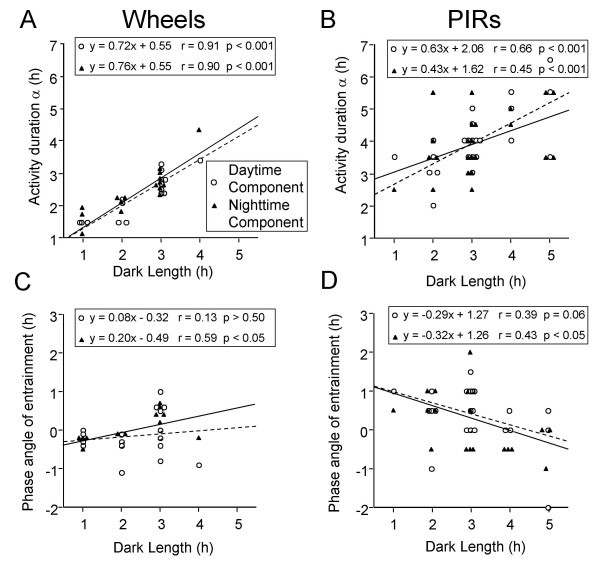
Scatterplots of activity duration (A, B) and phase angle of entrainment (C, D) as a function of entraining photocycle in split hamsters with running wheels (A, C) or without (B, D). Least squares regression lines for the daytime (open circles; dashed lines) and nighttime (filled triangles; solid lines) were calculated separately.